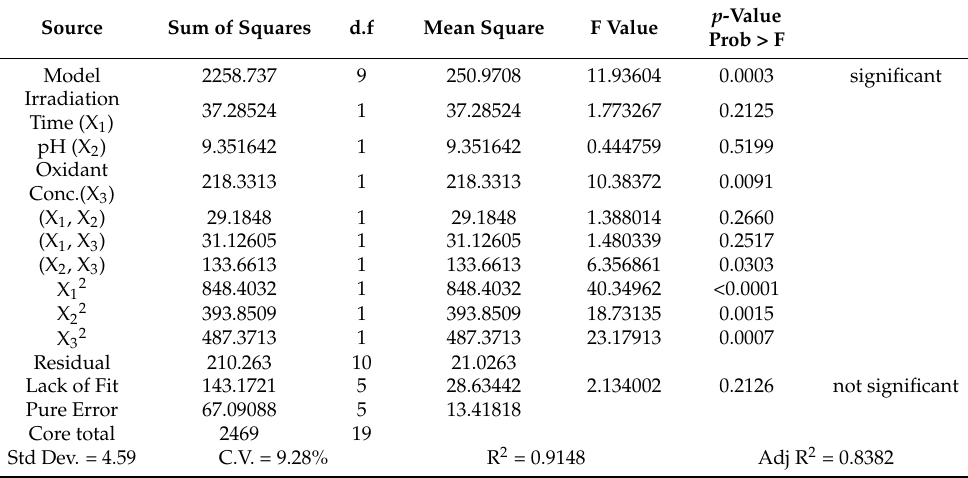
Table 4. ANOVA for face-centered composite design experimental value of % age degradation efficiency of the insecticide solution treated with basic prewetted pH on nanocalcite @ PF.